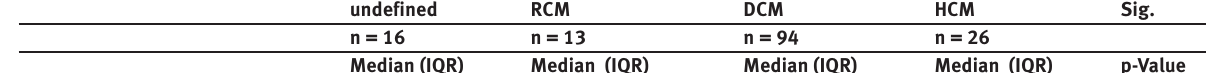
Table 1: Laboratory measurements according to the CMP morphological